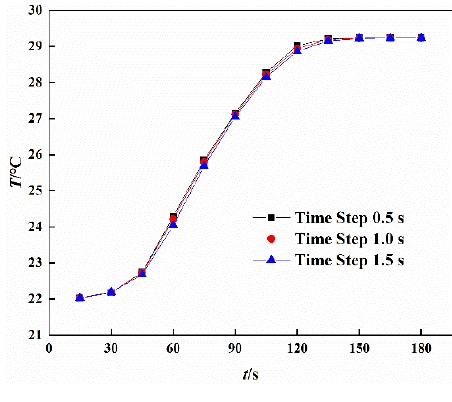
Figure 4. Independent analysis.